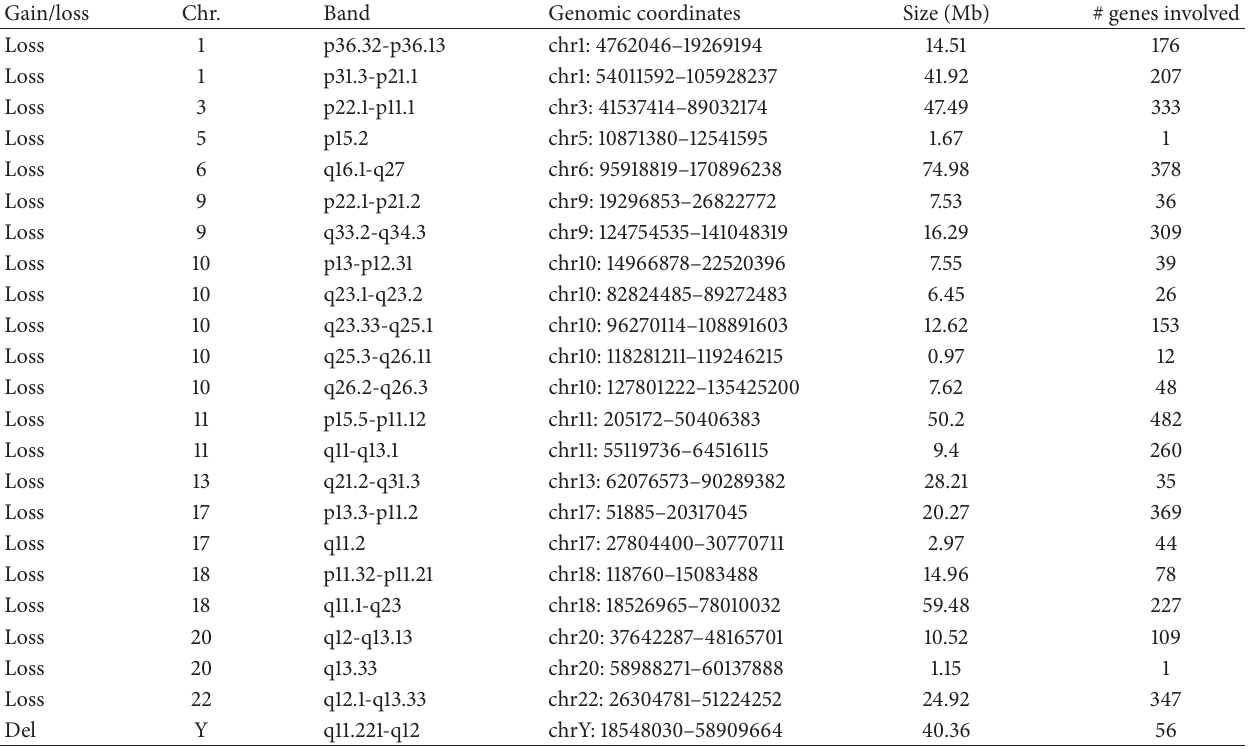
Table 2: Pleural tumor chromosomal alterations, cytogenetic band locations, genetic sizes, and the genes involved characterized by a-CGH. Gain/loss Chr. Band Genomic coordinates Size